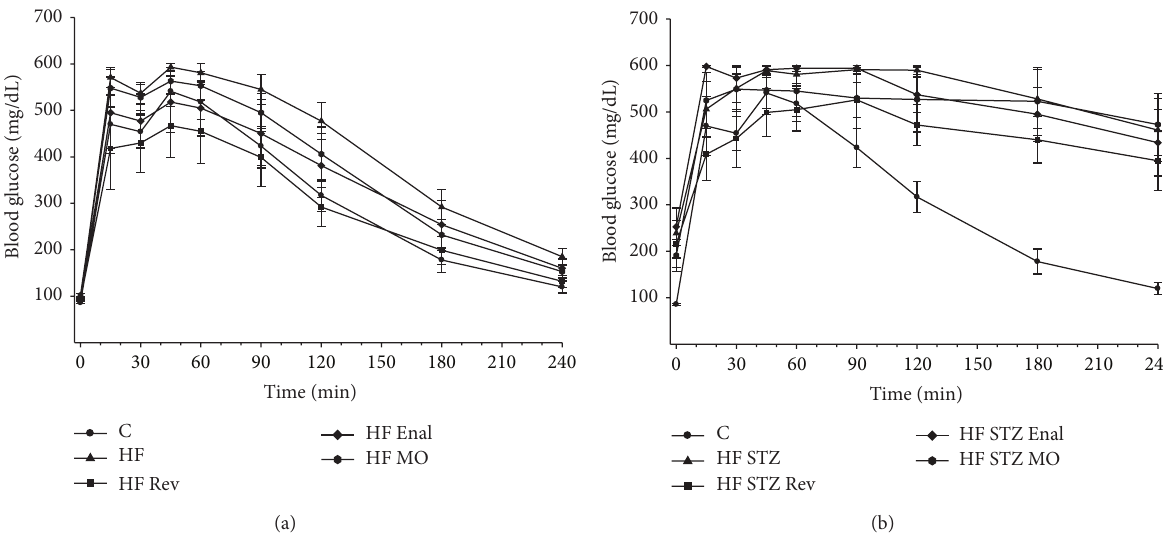
Figure 1: Effect of treatment of diet induced obese rats (a) and high fat fed/low dose streptozotocin type 2 diabetic rats (b) with normal diet, enalapril, or menhaden oil on glucose tolerance. Glucose tolerance was determined as described in Section 2. Data are presented as the mean ± S.E.M. in mg/dl. The number of rats in each group was the same as shown in Table 1. Control rats (C), diet induced obese rats (HF), diabetic rats (HF STZ), and rats returned to a normal diet or treated with enalapril or placed on a menhaden oil enriched diet designated as Rev, Enal, or MO, respectively.